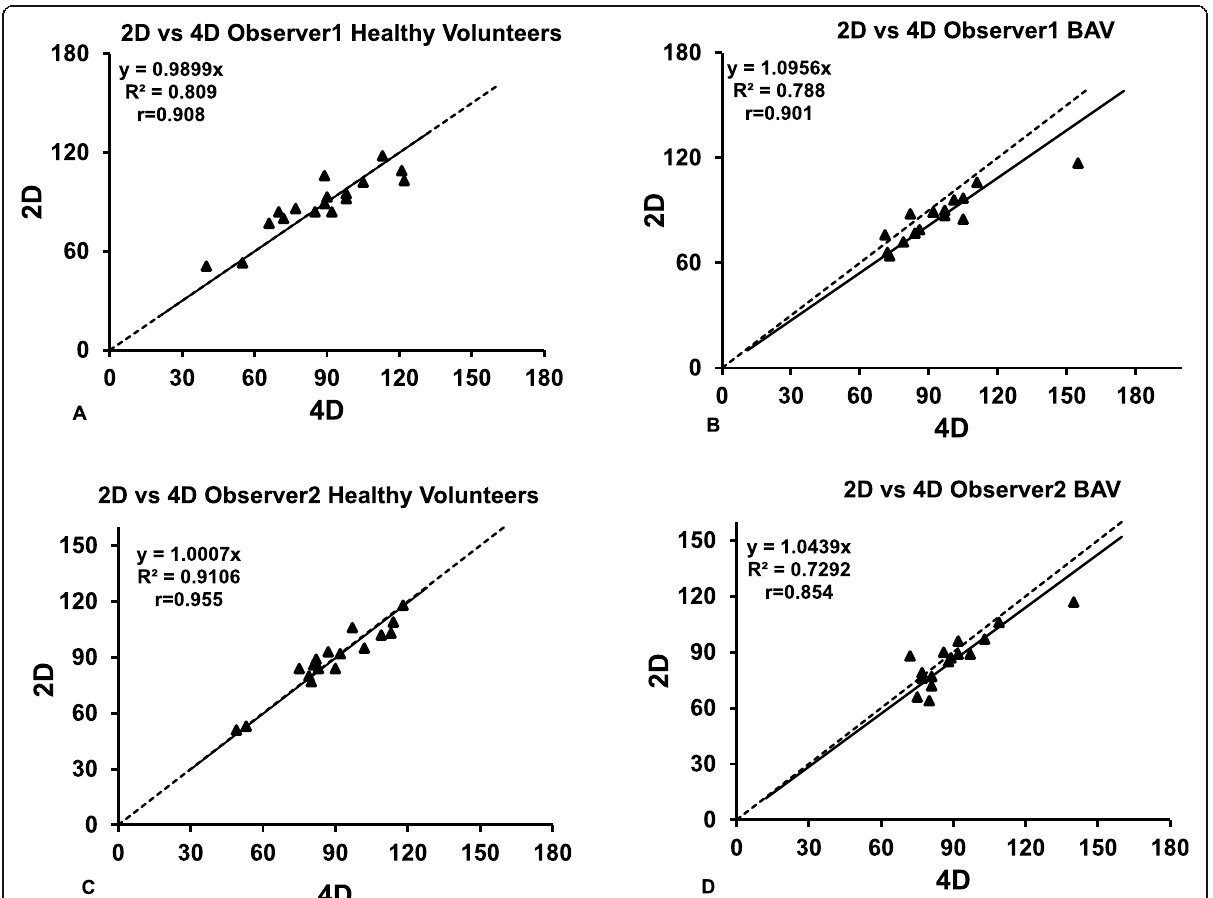
Fig. 3 Linear regression correlation: net flow values (ml) in the ascending aorta of both techniques by the two observers are plotted on both X - axis and Y -axis. The X-axis represents the four-dimensional (4D) method of flow analysis while the Y -axis represents the two-dimensional (2D) method of flow analysis in all four graphs. Graphs a and c represent healthy volunteers, b and d represent patients with bicuspid aortic valve (BAV). A line of identity (dashed) y = x is added. The regression line (solid) indicates the offset between the two